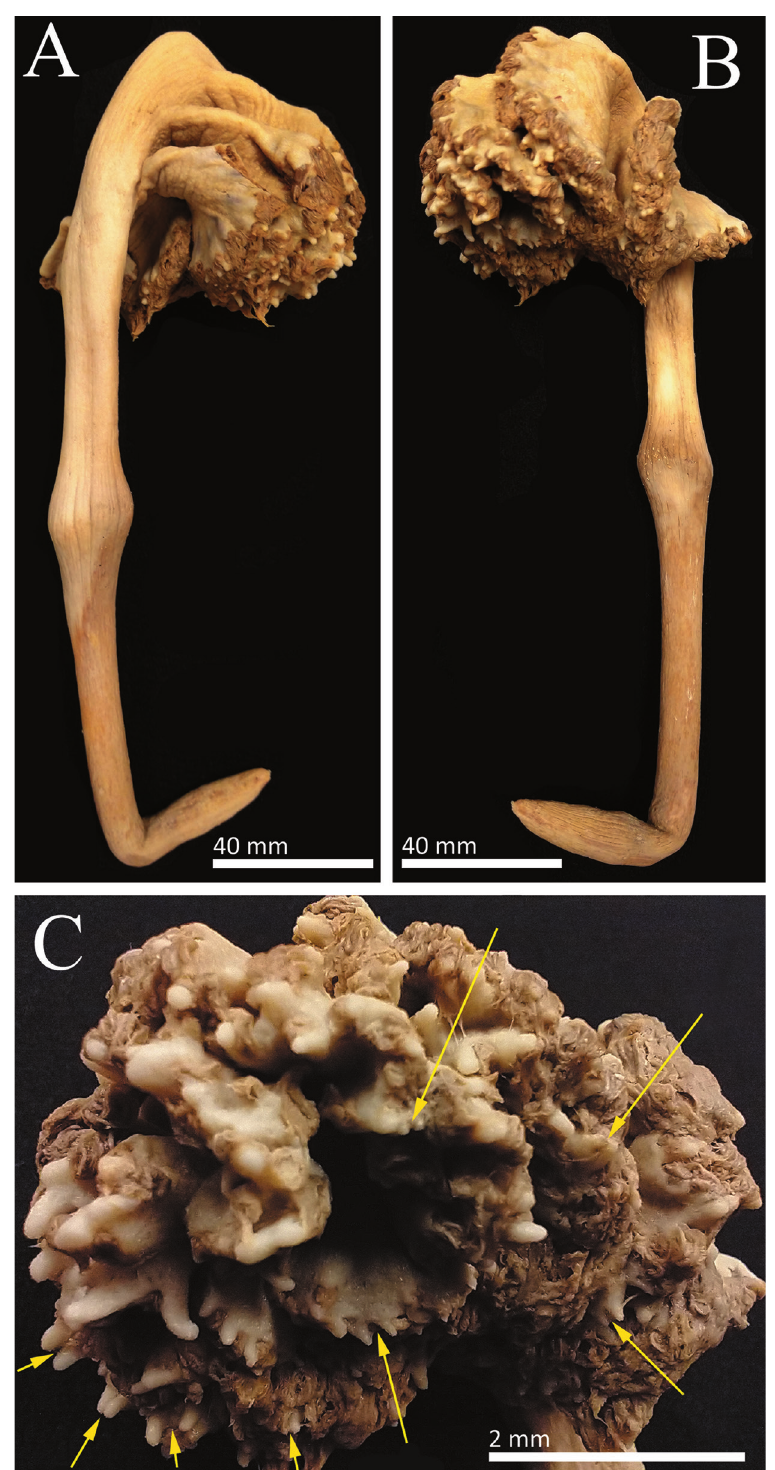
Fig. 12. Gyrophyllum cf. sibogae Hickson, 1916, colony from New Zealand waters (NIWA 158583; sampling data: NZOI Stn. P86, 31º39.498′ S, 159º9.402′ E, 610 m depth, 28 May 1977). A . Latero- dorsal side. B . Latero-ventral side. C . Detail showing polyp leaves ventral edges with well-developed BPPs (yellow arrows) in a double manner. These are likely to be the origin of Hickson’s observations, but despite this, Indo-West Pacific colonies deserve further molecular and morphological